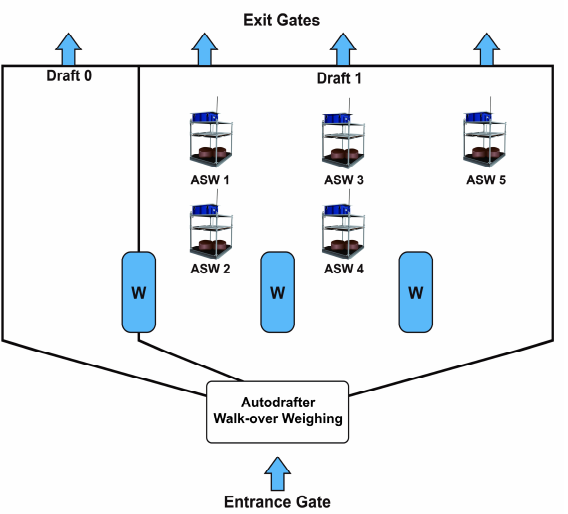
Figure 4. The layout of the experimental sites where the automatic supplement weighing (ASW) units, water troughs (W), and walk-over weighing were installed on each site. The total area of Draft 0 and Draft 1 was 3500 and 10,500 m 2 ,